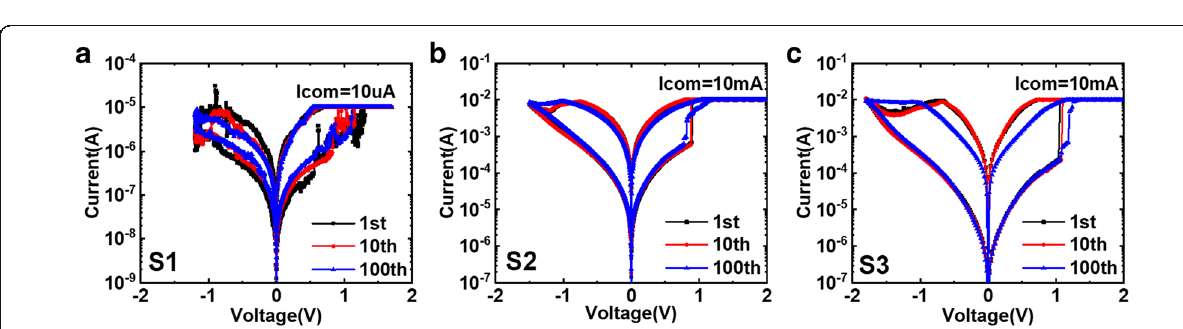
Fig. 5 100 cycles stable bidirectional I-V curves in a S1, b S2, and c S3